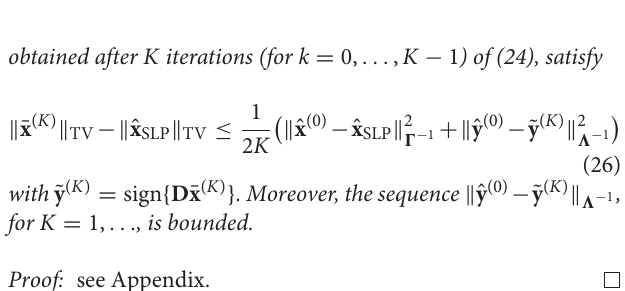
1 = 1 / i . We aim at recovering the graph a graph signal from the observations ˜ x 1 = 1 and +